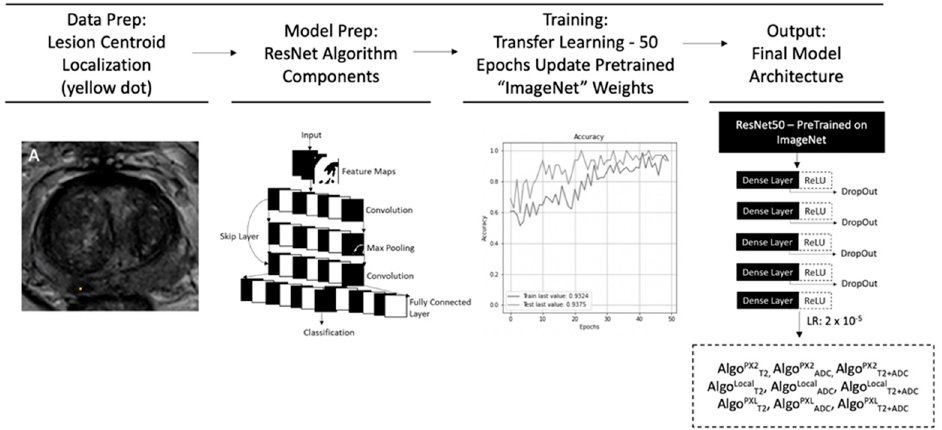
Figure 1. Algorithm generation depicting data and model preparation, and ResNet model training and architecture used to develop the final models. Image A depicts T2W sequence with dot labeling the centroid of a Gleason 4 + 4 lesion. ReLU: Rectified linear unit activation function; LR: learning rate; Algo: algorithm.